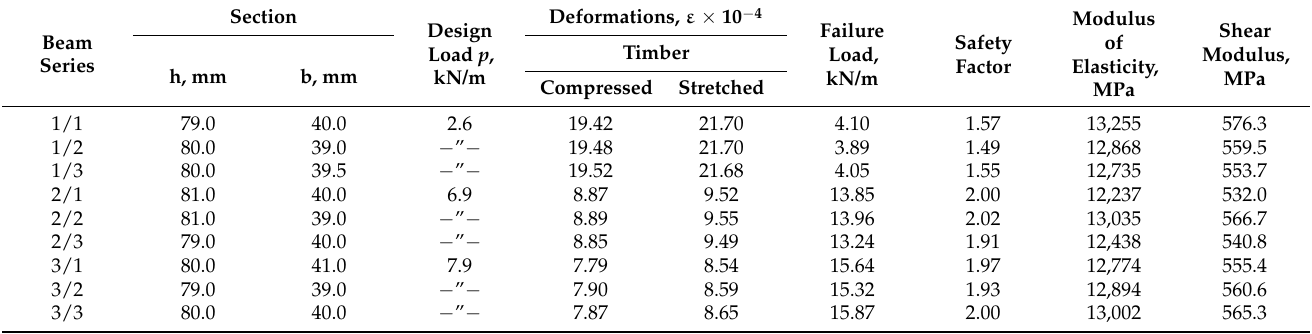
Table 1. Beam experimental test